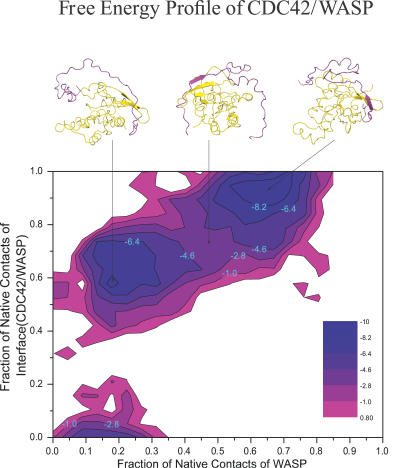
Typical Structures and their Corresponding Configuration in the Free-Energy LandscapeTypical structures of loosely bound state (left structure), transition state (middle structure), and bound state (right structure) and their corresponding configuration in free-energy profiles in terms of fraction of native (interface) contacts between Cdc42 and CBD portion of WASP, as well as the fraction of native (folding) contacts of CBD itself.